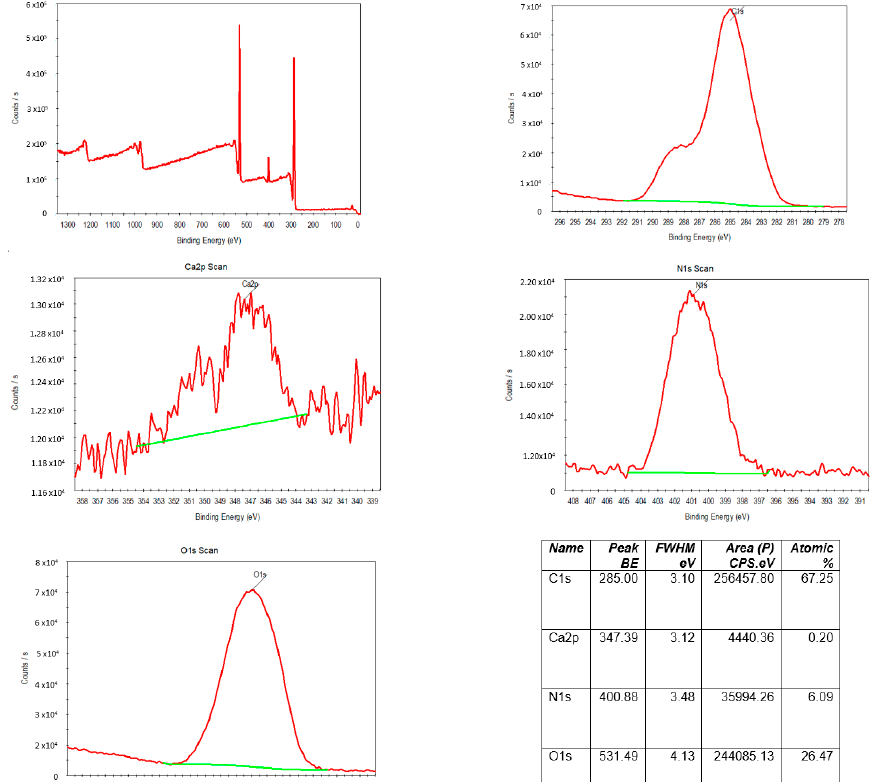
Figure 7. X-ray photoelectron spectroscopy—L-glu spheres crystallized from 54 mM L-glu and 11 mM Ca 2+ ions.